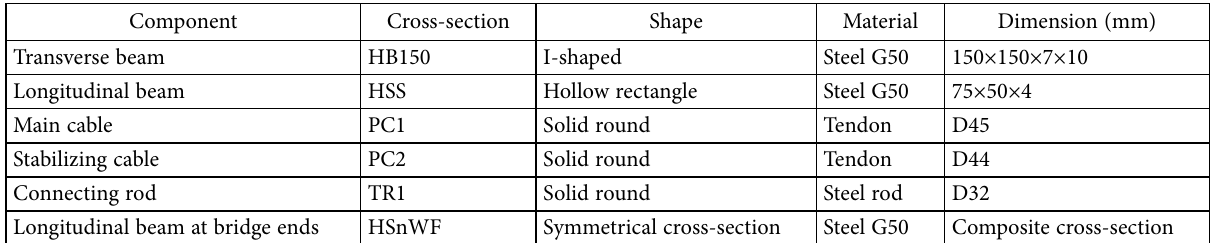
BridgeFigure 13. Finite-element model of Baishihu Figure 14. Analysis results of cable forces under dead weight Suspension of Baishihu Table 5. Parameters of structural cross-sections